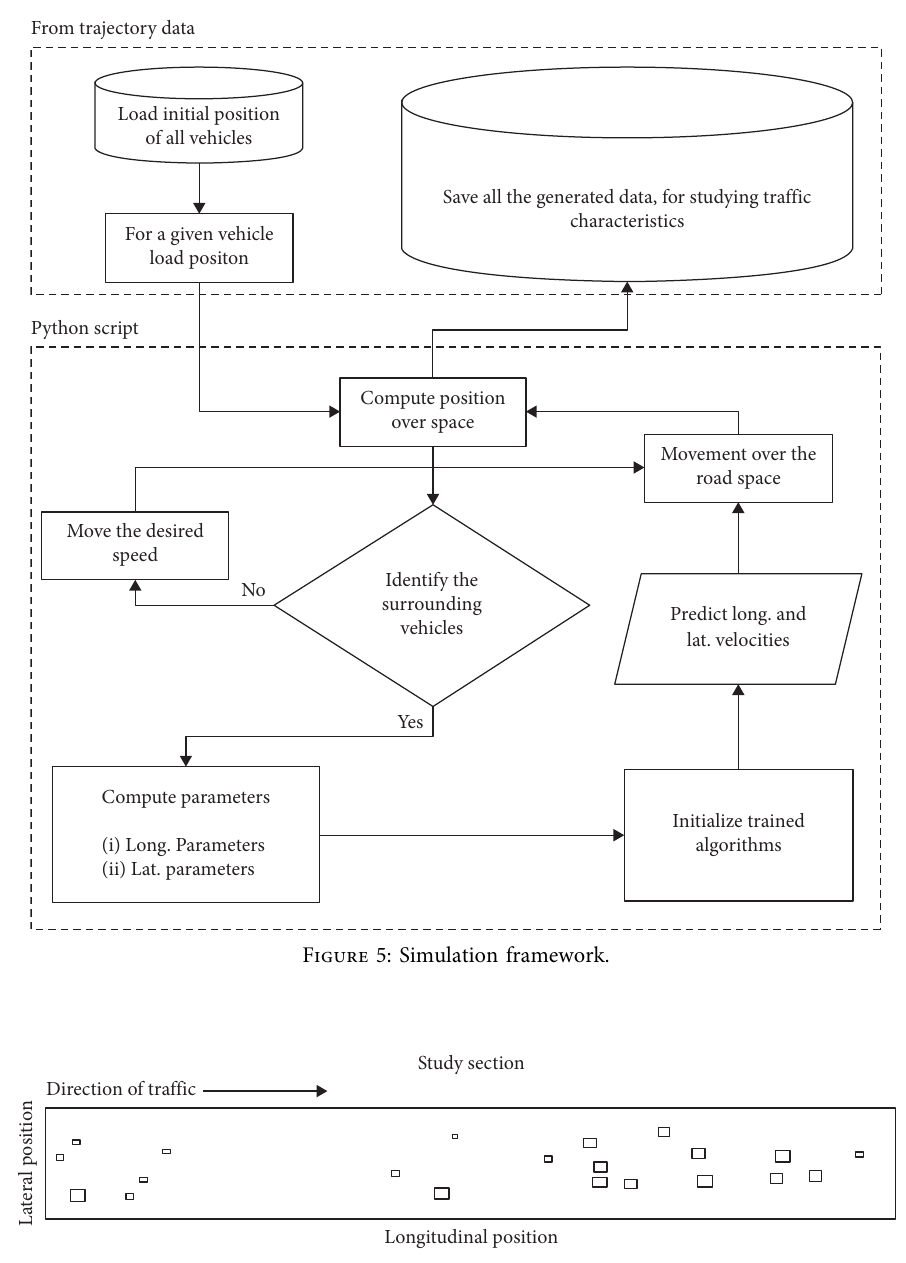
Figure 6: Snapshot of simulated movement of vehicles under mixed traffic